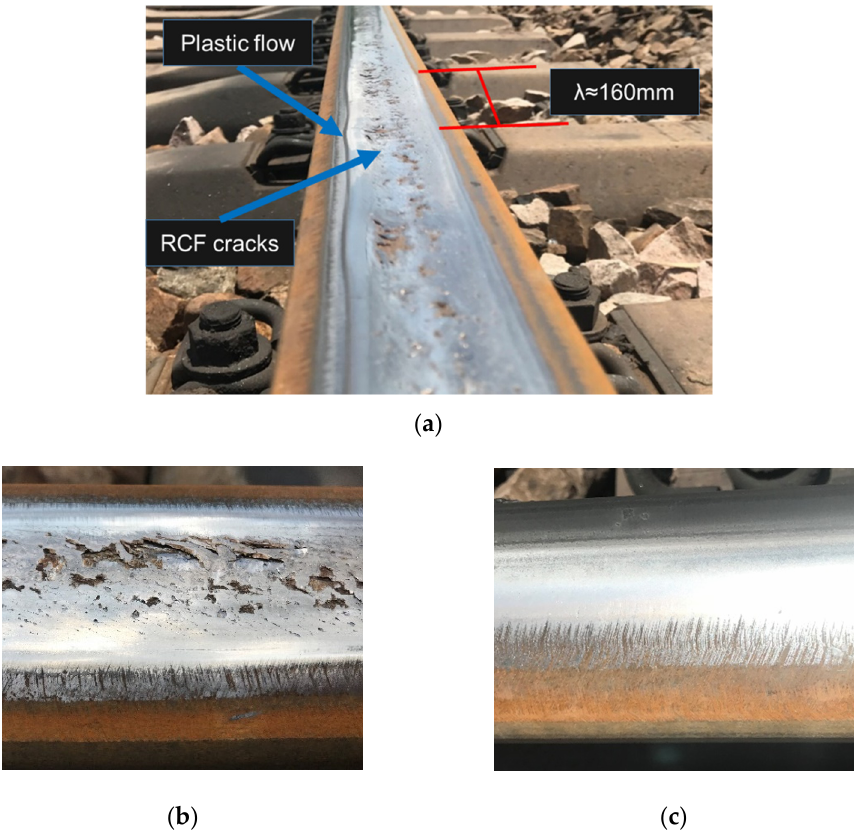
Figure 1. Typical corrugation cases and rail surface conditions: ( a ) typical rail corrugation in the field; ( b ) inner rail, the surface damage is serious; ( c ) the outer rail is in good condition.